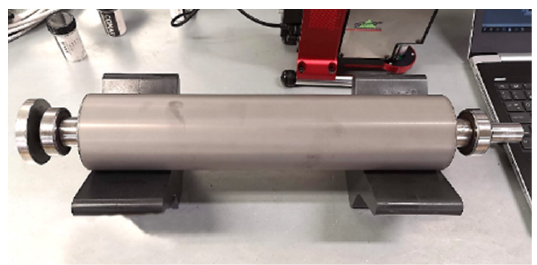
Figure 4. Anilox roller prepared for measurement.